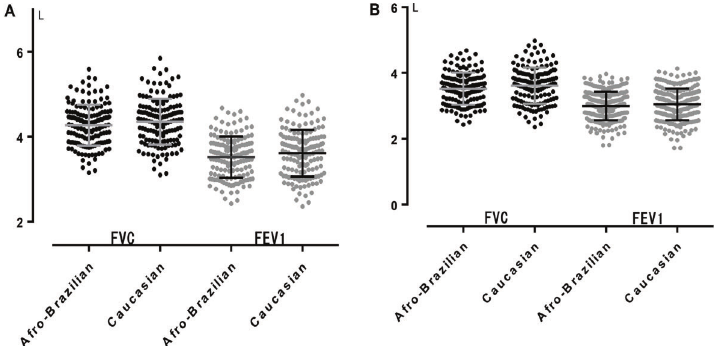
Figure 2. Forced vital capacity (FVC) and forced expiratory volume in 1 second (FEV1) in two Brazilian ethnicities. Horizontal lines indicate mean ±